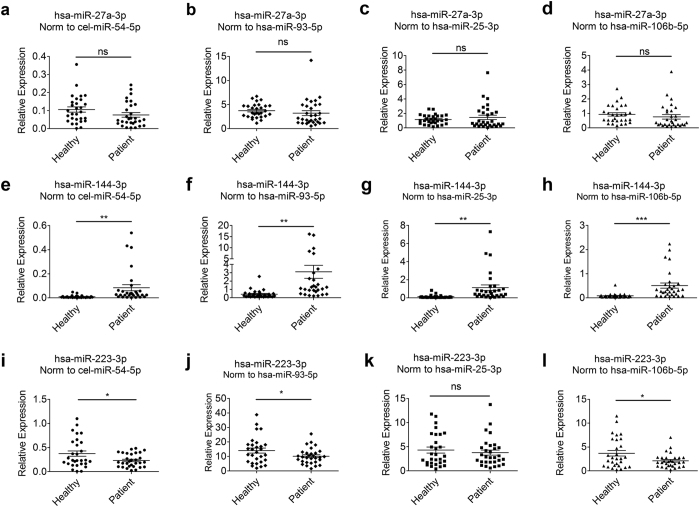
Expression levels of hsa-miR-27a-3p, hsa-miR-144-3p and hsa-miR-223-3p in colorectal cancer and healthy control.miRNAs were quantified in the plasma of 30 colorectal cancer patients and 30 healthy individuals. miRNA levels were normalized to cel-miR-54-5p (dot), hsa-miR-93-5p (diamond), hsa-miR-25-3p (square) and hsa-miR-106b-5p (triangle) respectively. Data are shown as means ± SE, ns = not significant, *P < 0.05, **P < 0.01 and ***P < 0.001.